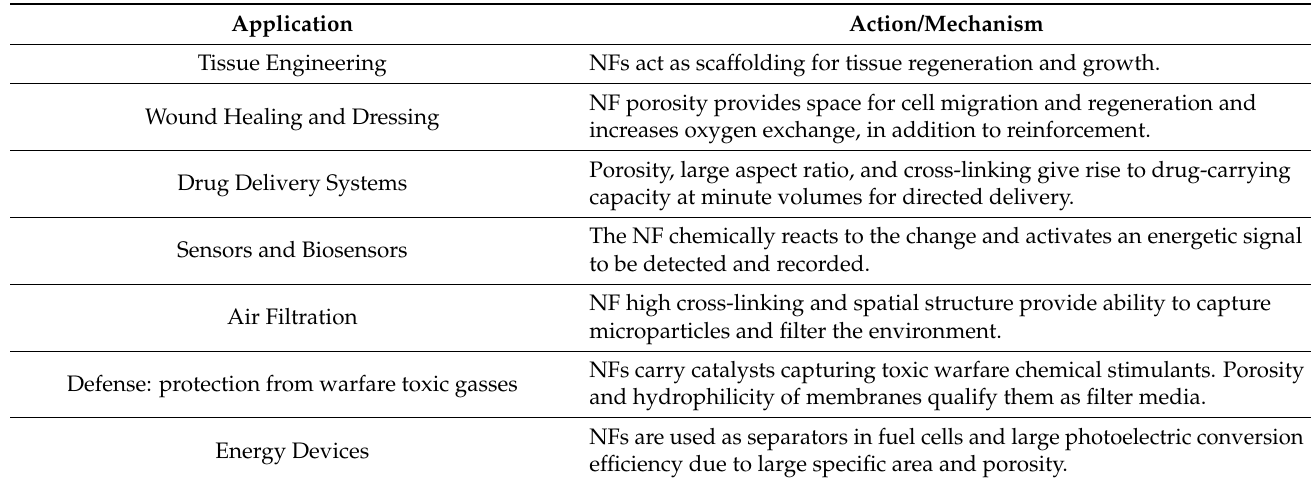
Table 6. Nanofibers’ mechanisms of action in different